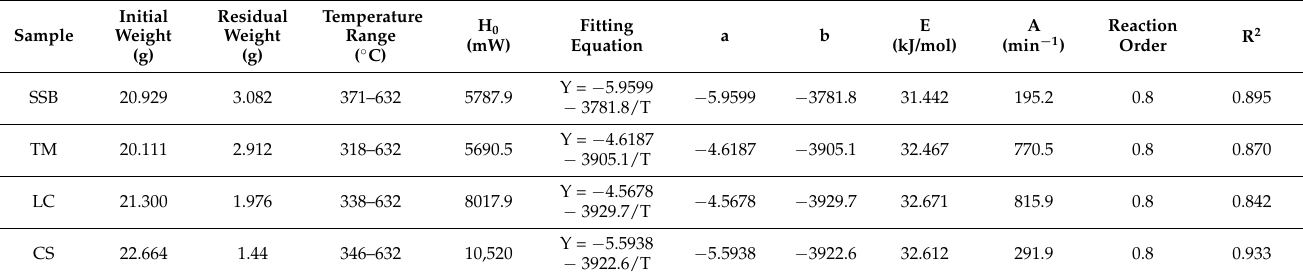
Table 3. Results of pyrolysis kinetics of DSC.